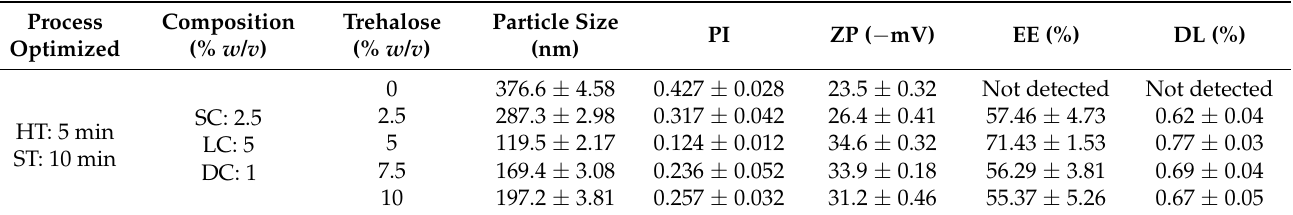
The uptake of plain curcumin and Cur-SLNs was found to be 162.4 ± 4.2 ng/ µ g and 682.08 ± 6.33 ng/ µ g, respectively. The results demonstrated a 5.2-fold increase in cellular uptake of curcumin from Cur-SLNs than from plain